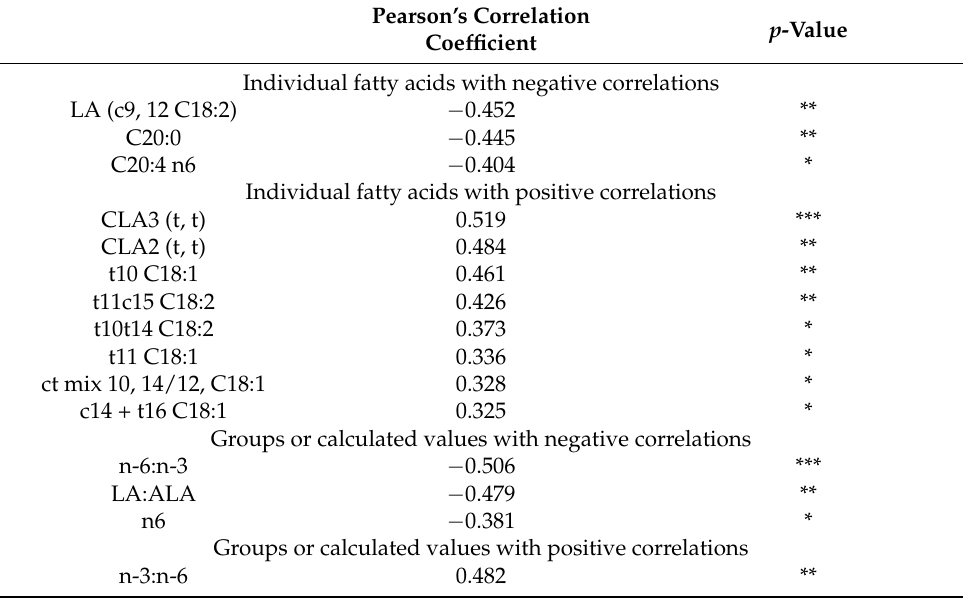
Table 3. Outcome of correlation analysis using fatty-acid profiles (% total fatty acids) and recorded methane emissions (g/cow/day) (showing those with p -values < 0.05). Pearson’s Correlation p -Value Coefficient